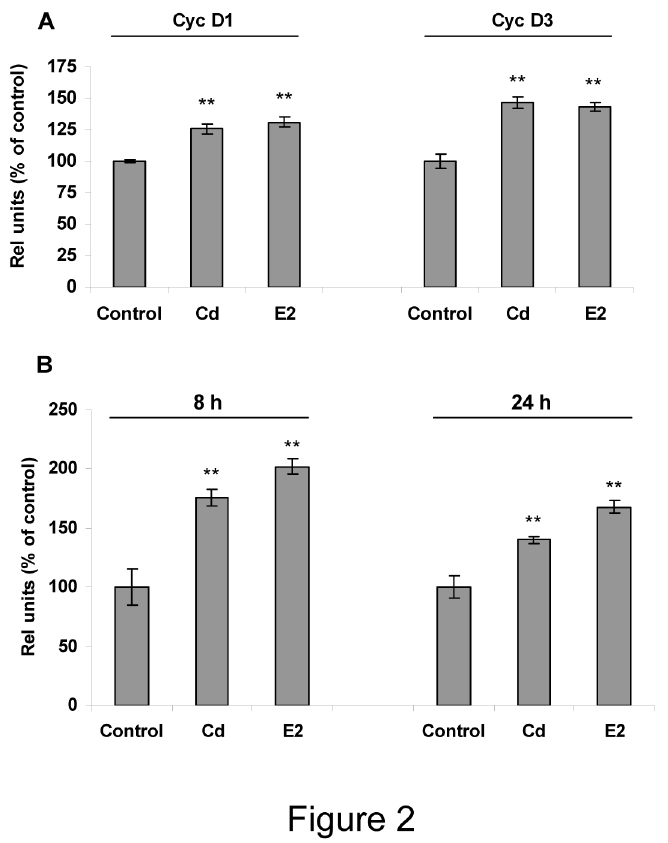
Figure 2. Cadmium increases gene expression of proliferation markers in anterior pituitary cells. Anterior pituitary cells were treated with vehicle (control), 10 nM Cd or 1 nM E2. Gene expression was evaluated by PCR. Bars represent the mean ± SE of densitometric values of cyclins D1 and D3 after 72 h (A) or c-fos after 8-24 h (B) normalized to GAPDH expression and are expressed as percent of control. ANOVA followed by Tukey-Kramer’s test, *p<0.05, **p<0.001 vs. control (N=3). doi: